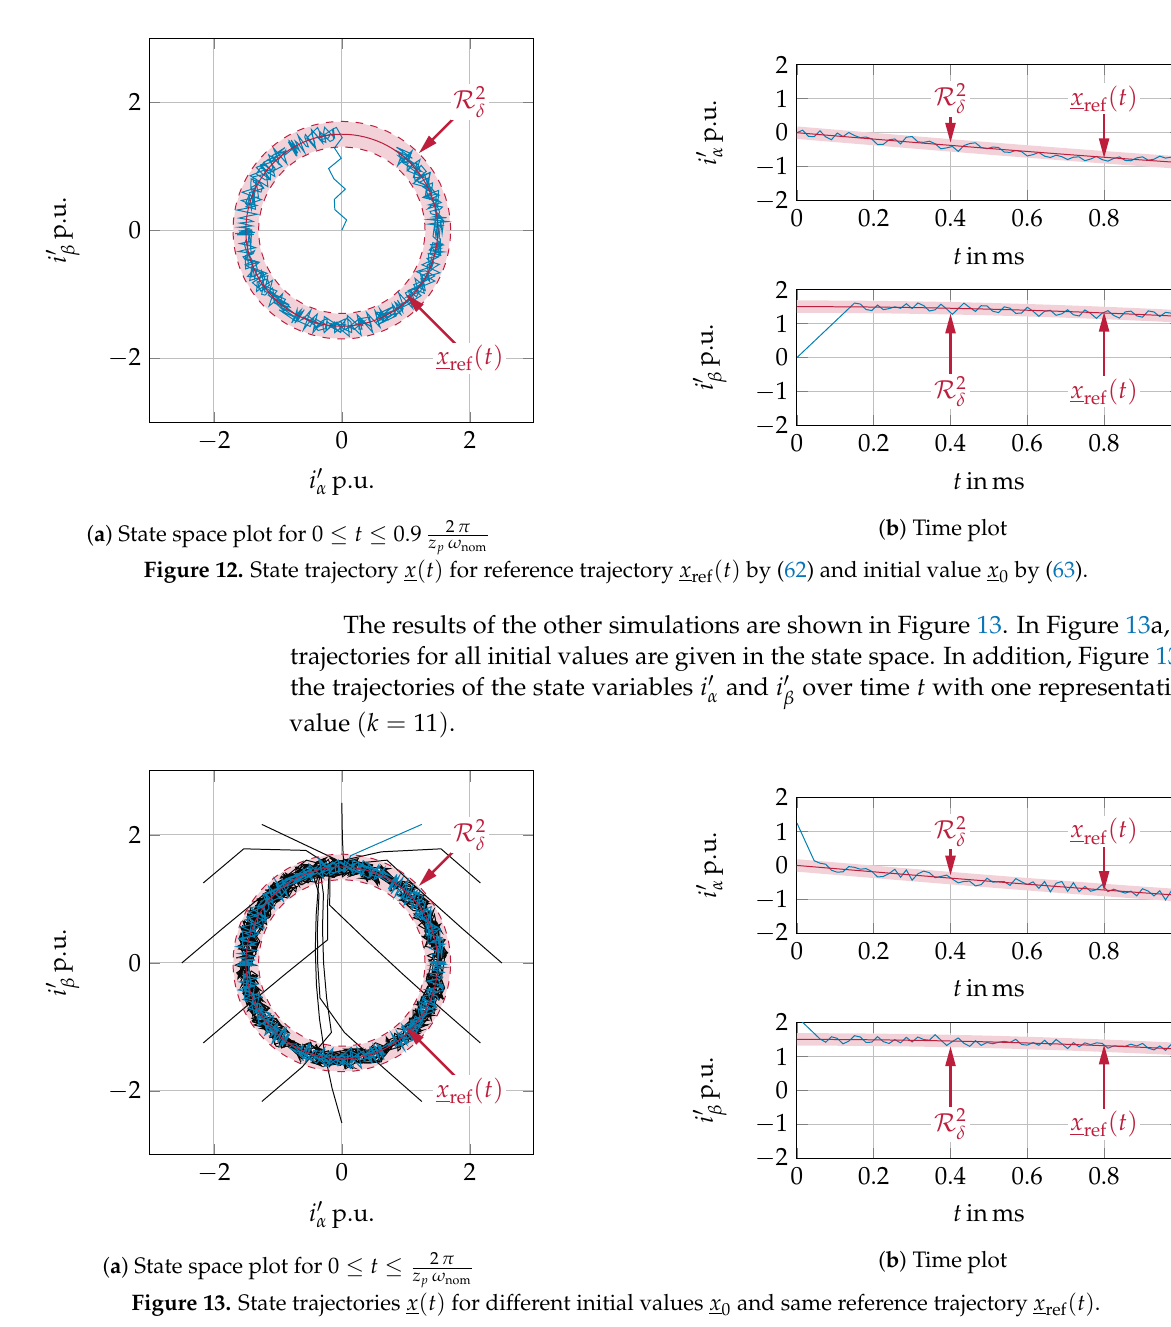
Figure 13. State trajectories x ( t ) for different initial values x 0 and same reference trajectory x ref ( t )